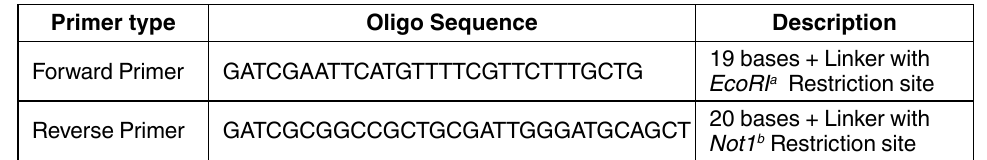
table 1. DNA Primer sequences for cloning CP8 gene into pPICZα A vector Primer